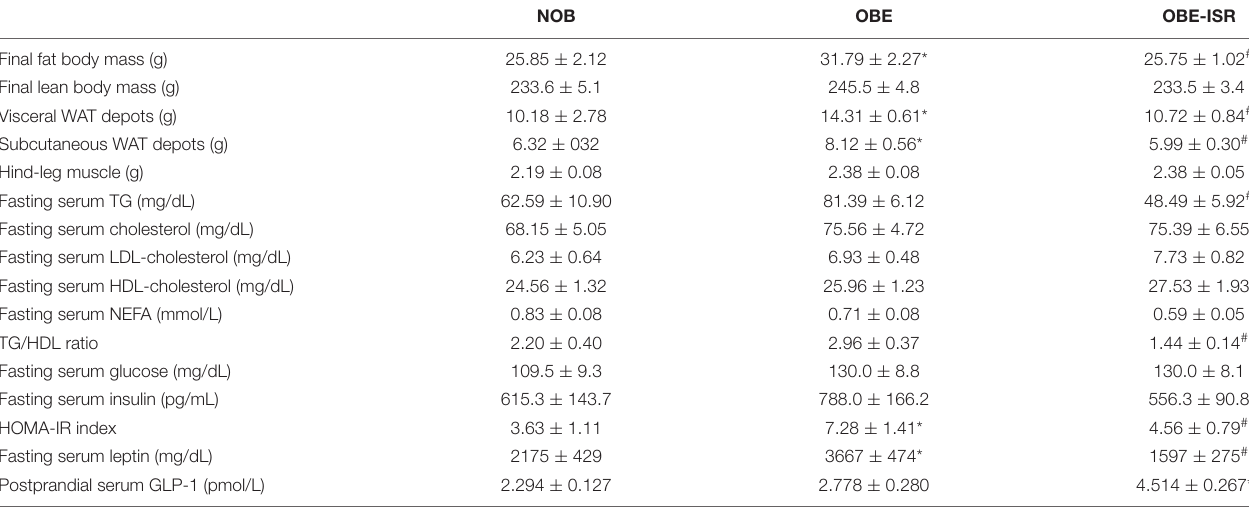
TABLE 2 | Body composition and serum biochemistry of the different experimental groups fed on the different experimental diets for 4 weeks to induce obesity. NOB OBE